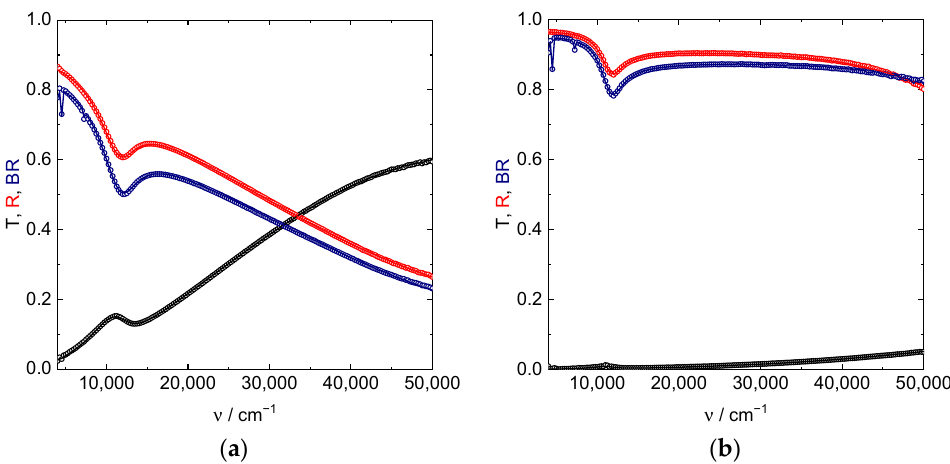
Figure 7. Fit examples for samples from series 2: experimental spectra (triangles) and fit (lines). ( a ) d = 8.0 nm; ( b ) d = 29.7 nm. The samples are identical to the evaporated samples shown in Figure 5. Table 5. Dispersion parameters of series 1 films (sputtering).